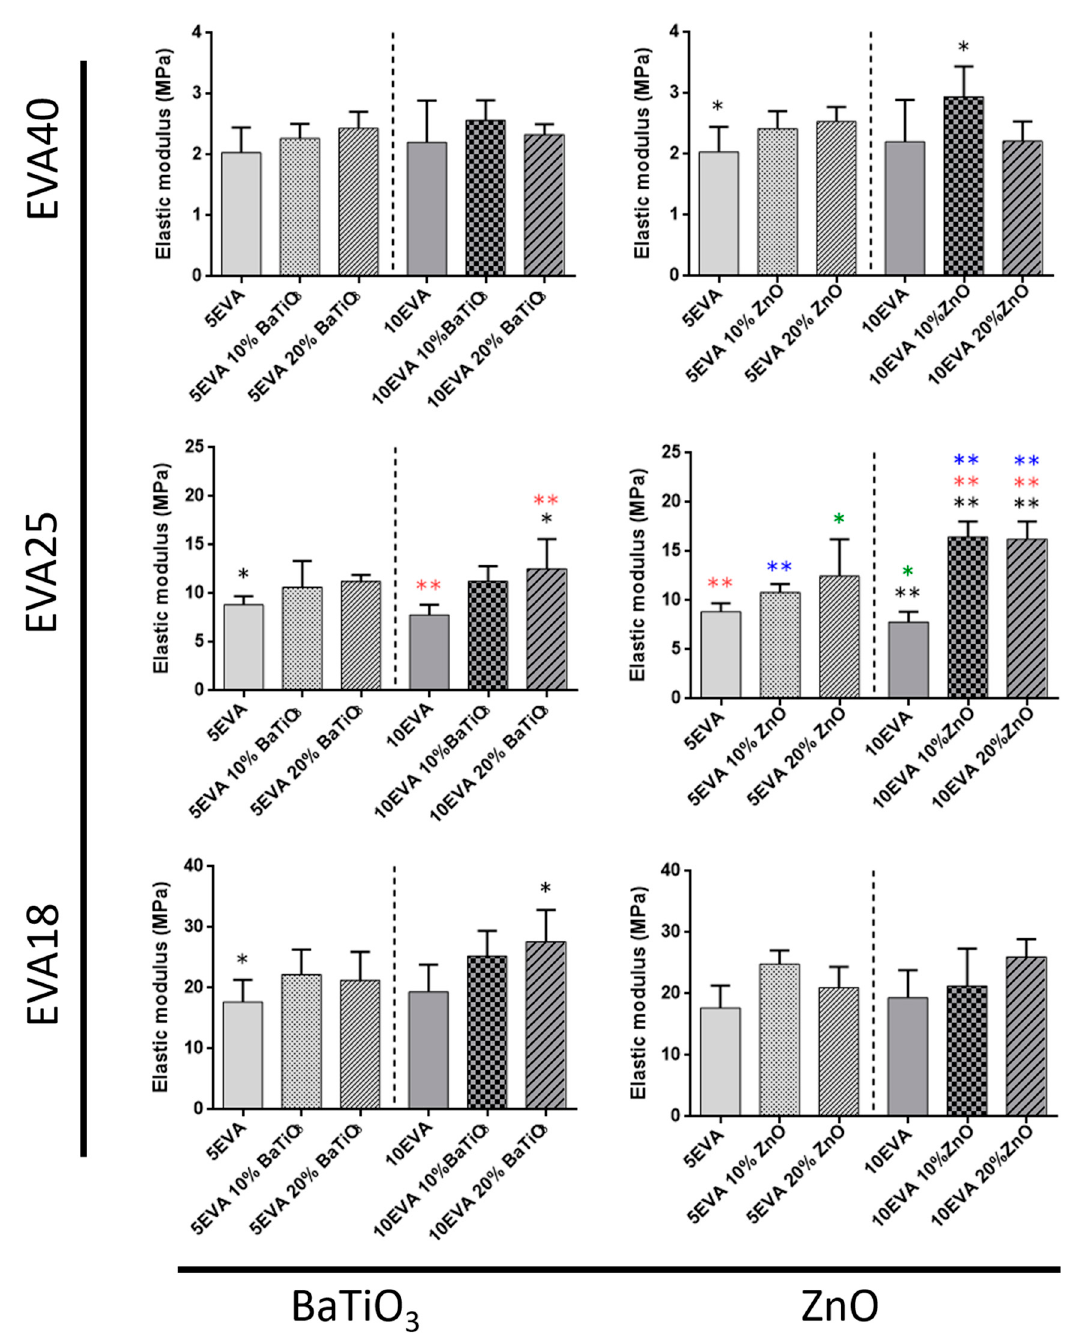
Figure 4. Elastic modulus of nanocomposite EVA-based matrices subdivided for the content of vinyl acetate and the ceramic nanomaterial included. * = p < 0.05, ** = p < 0.01. Different colors have been used to evidence the statistical significance between the compared cases in each graph.